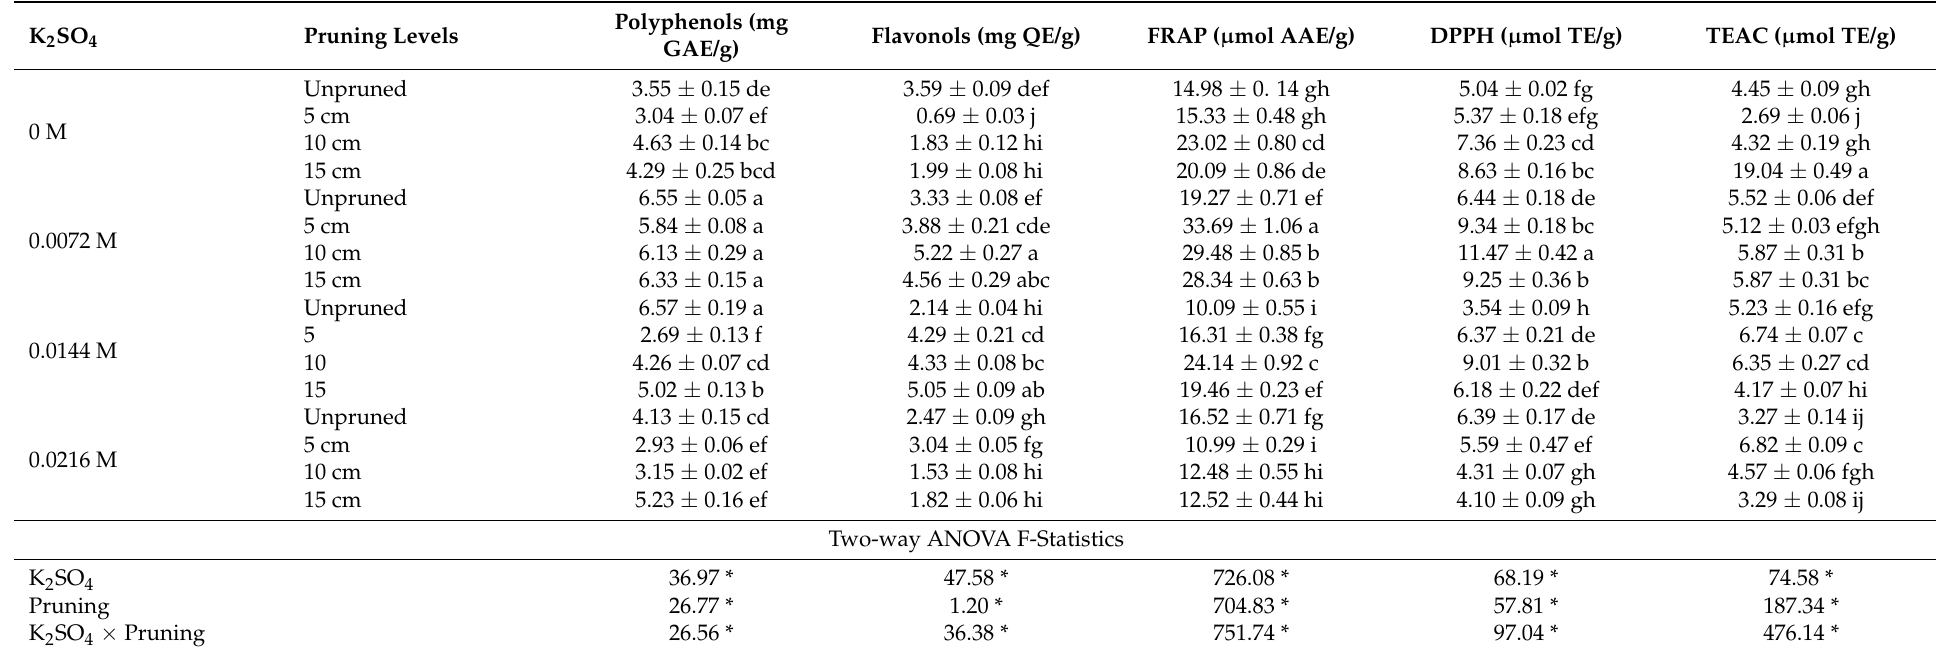
Table 5. The effect of potassium concentration and pruning level on phytochemicals and the antioxidant activity of flower buds of T. divaricata . K 2 SO